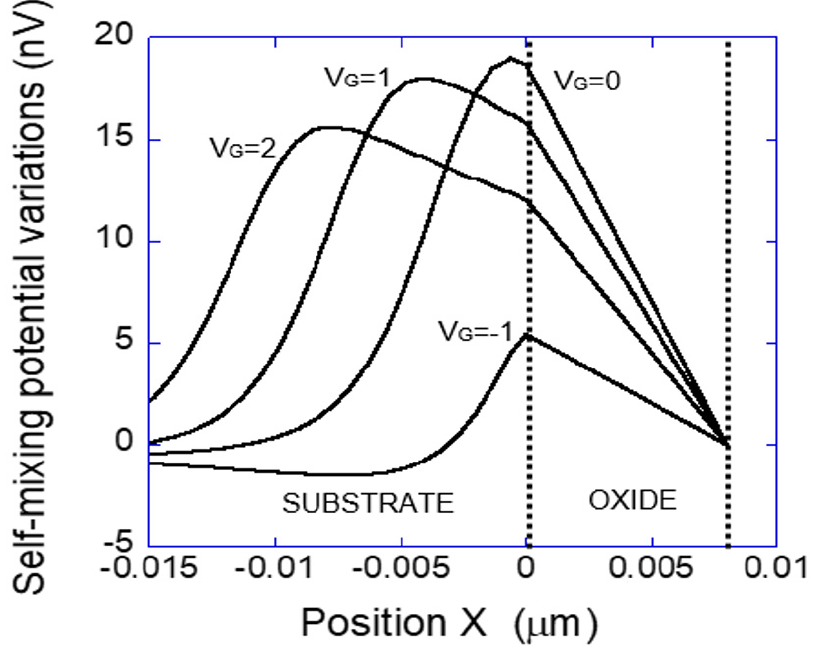
Figure 3. Distribution of DC potential generated by self-mixing in the substrate, shown along the Y cut at y = 0, under 1 mV RF gate voltage at 1 THz, at di ff erent gate